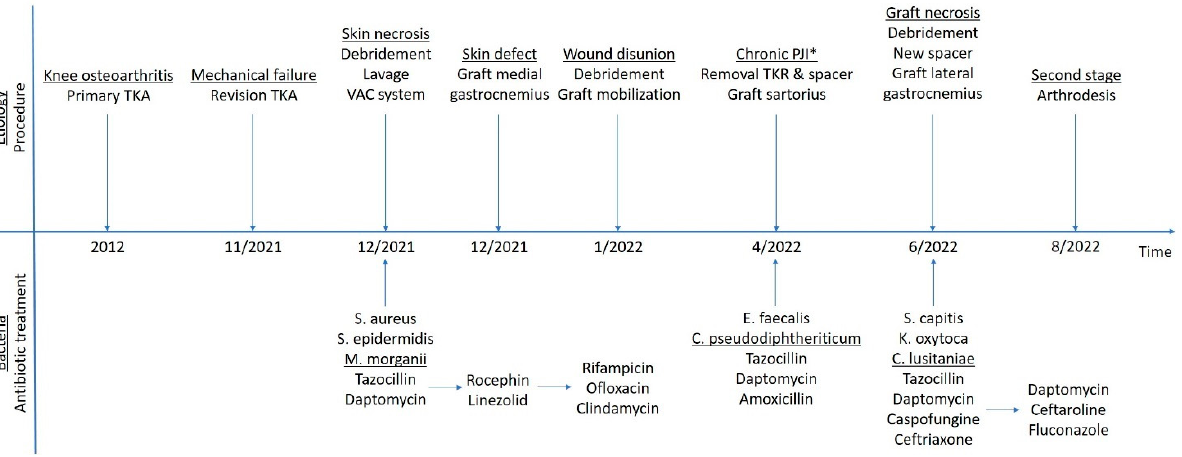
Figure 5. An overview of the patient’s clinical course. (*) represents the point in time that the deci- sion to remove the implants was made.